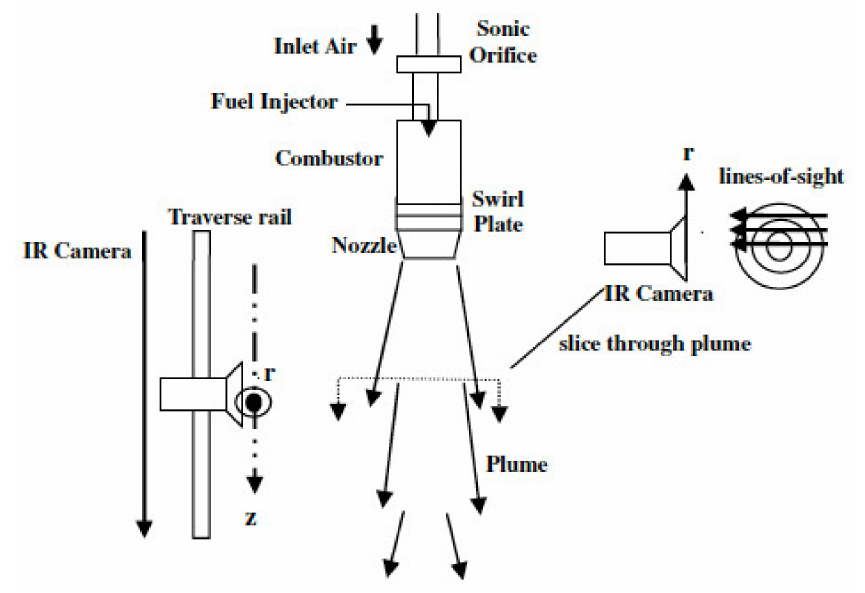
Figure 2. Set-up for investigating radiation in exhaust plumes (from